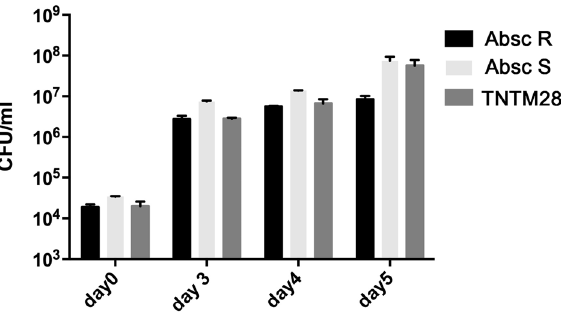
Figure 6. Growth of TNTM28 in THP-1 human macrophages as compared to smooth and rough M. abscessus variants (Absc S and Absc R, respectively). The number of CFU was determined at the indicated times post- infection. Error bars indicate the s.e.m., based on the results from 3 independent